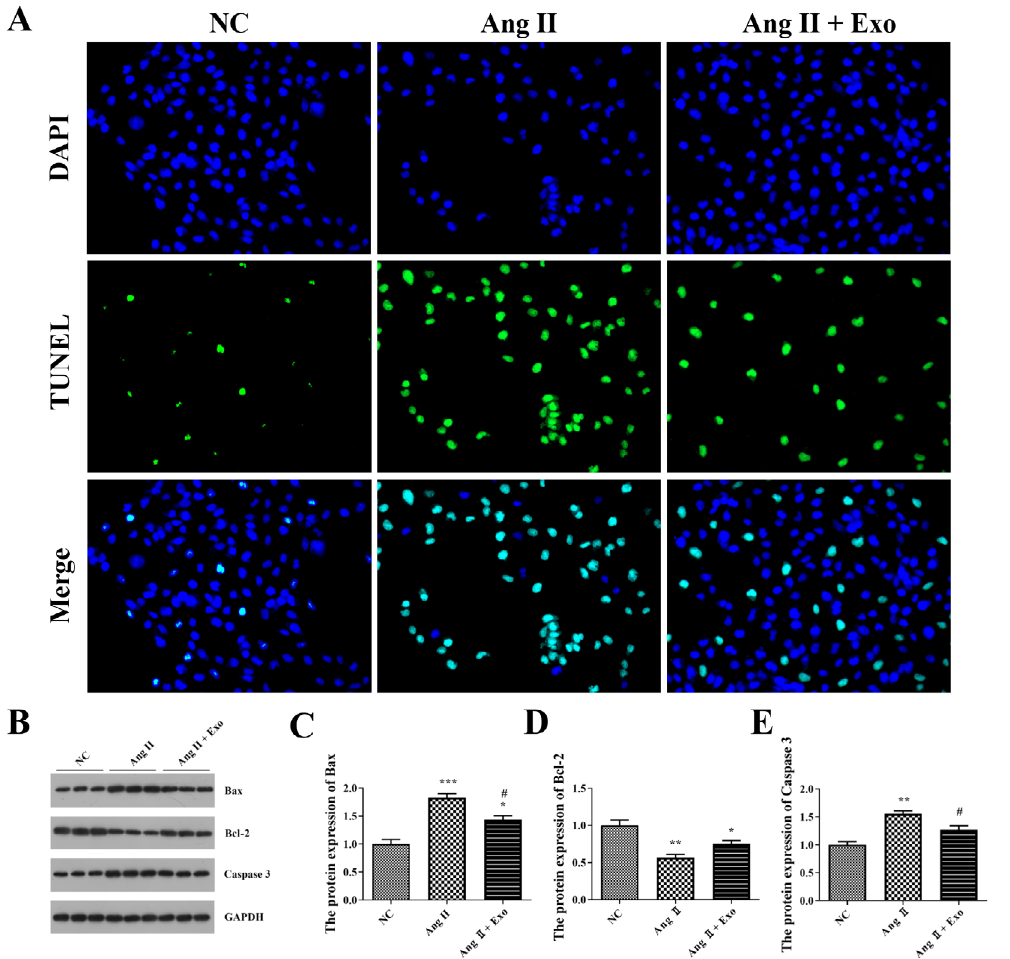
Figure 4 – Anti-apoptosis effect of MSCs-exosomes on hypertrophic cardiomyocytes. A. The apoptosis test of H9c2 cells by terminal deoxynucleotidyl transferase (TdT) dUTP Nick-End Labeling (TUNEL) assay. Apoptotic cells were clearly identified with a strong nuclear green fluorescence (FITC). Cell nuclei were visualized as blue fluorescence (DAPI, 4’,6-diamidino-2-phenylindole). B-E. Expression levels of B-cell lymphoma-2 (Bcl-2), Bax, and caspase 3 in H9c2 cells were detected by western blotting. H9c2 cells were treated with Ang II or with Ang II + exosomes (Exo). * P < 0.05, ** P < 0.01, and *** P < 0.001 vs. the NC group; # P < 0.05 vs. the Ang II